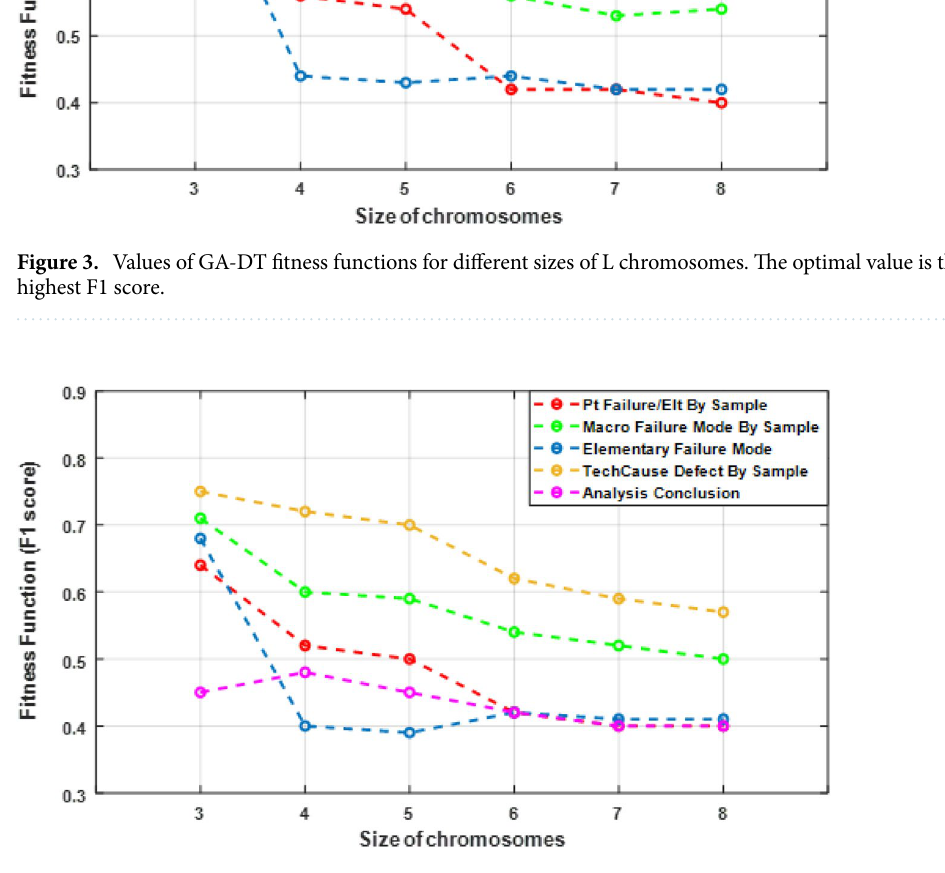
Figure 4. Values of GA-SVM fitness functions for different sizes of L chromosomes. The optimal value is the highest F1